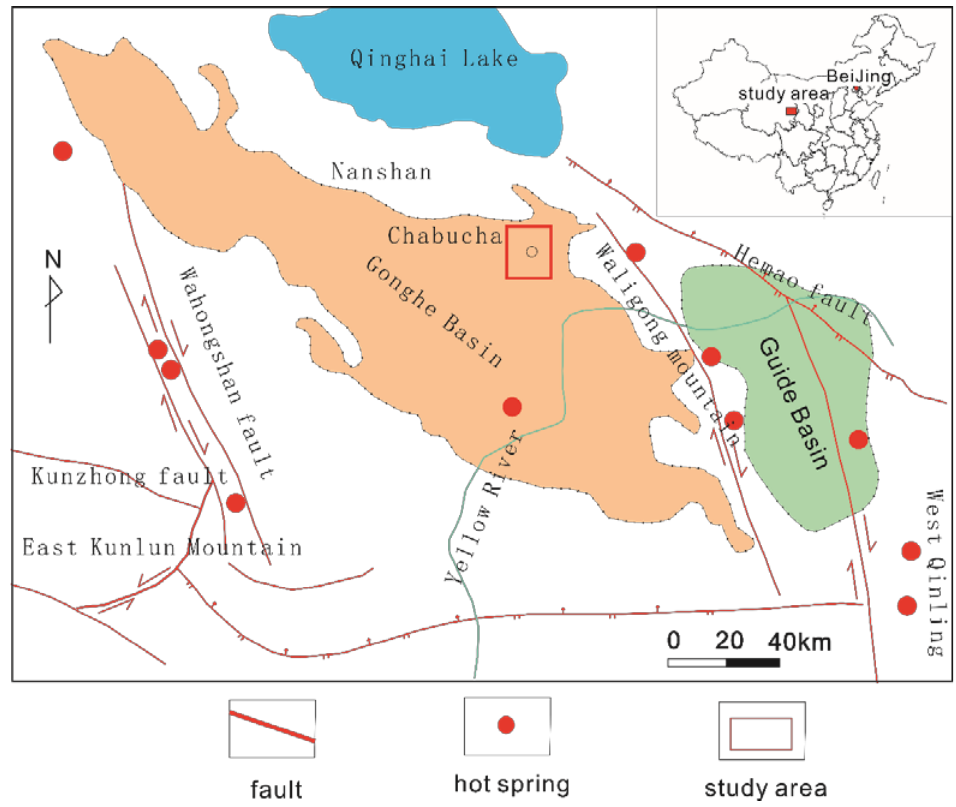
Figure 1. Simplified geological map of Gonghe Basin. The study area is located in the red area. Zhang et al. measured the thermal conductivity of Q al − l g and N 2 l at an average of 1 − 2 1.59 W/ (m·k), less than 2.51 for granite in the laboratory, which constitutes a caprock of the geothermal reservoir in the Gonghe area [25]. According to the resistivity logging data of well GR1 (as shown in Table 1), the part shallower than 1340 m is mainly mudstone and sandstone with many aquifers with low resistivity and the part deeper than 1340 m is dominated by granite and trace mudstone with high resistivity. A difference in the resistivity of the underlying stratum in the Qiabuqia area can be inferred. This fact provides the geophysical basis to apply the WFEM method to this basin.